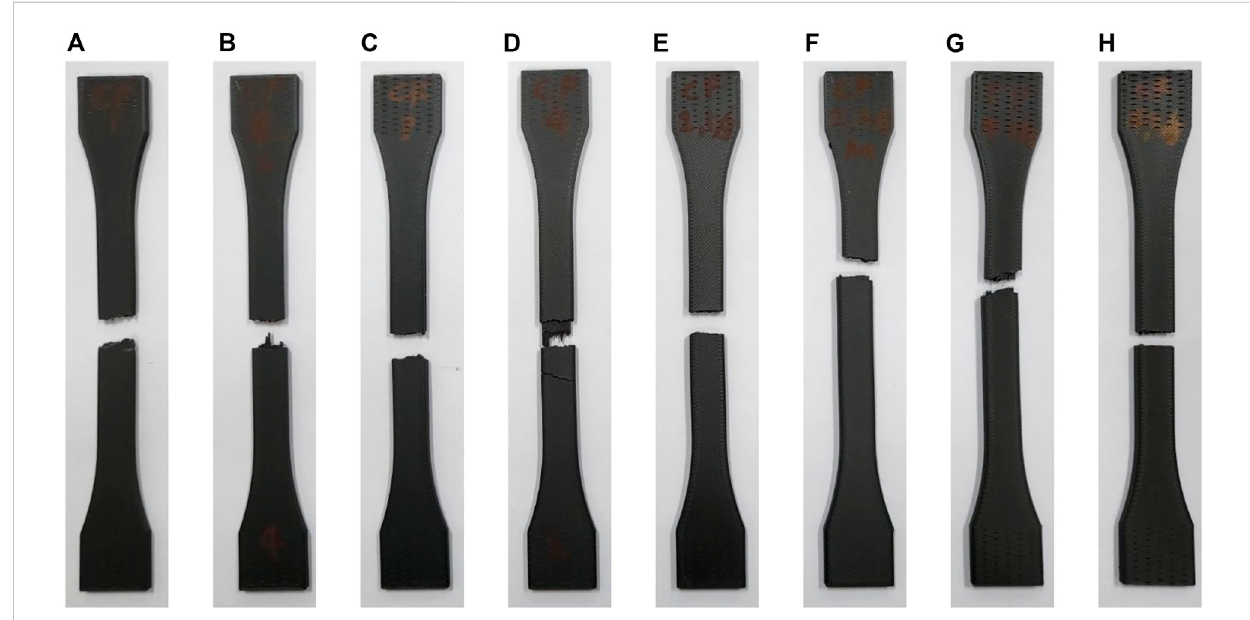
FIGURE 2 Shapeaftertensiletestofcompositematerialspecimenusingcarbon fi berasreinforcement (A) 1-layerreinforcement, (B) 2-layerreinforcement, (C)